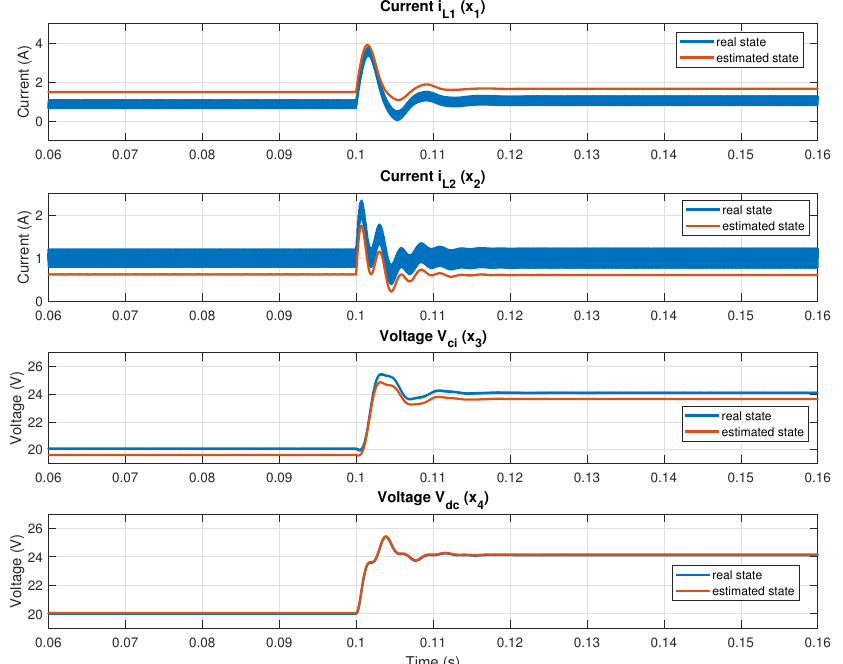
Figure 19. State observer performance under step changes at V b = 24